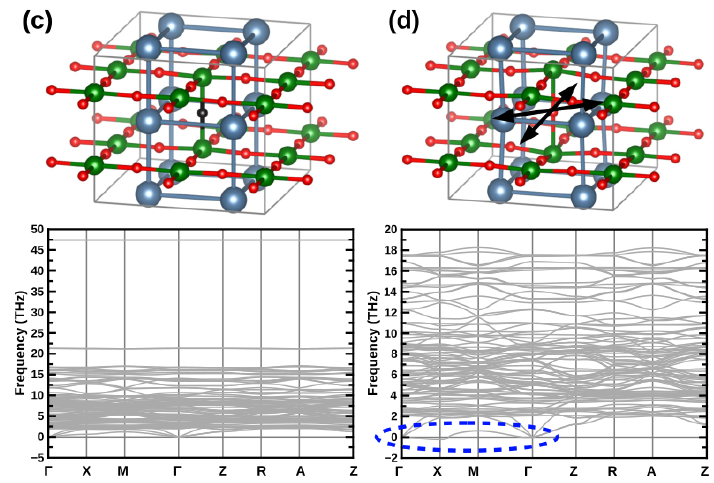
Figure 3. Phonon spectra of ( a ) LaNiO 2 and ( b ) LaNiO 2 H and in a 2 × 2 × 2 LaNiO 2 supercell doped with a single ( c ) H and ( d ) O atom (i.e., LaNiO 2 H 0.125 in ( c ) and LaNiO 2.125 in ( d )). The orange and black arrows in ( b , d ) represent vibrations of H and O atoms. The blue dashed oval in ( d ) labels the unstable phonon modes induced by intercalating additional O atoms in LaNiO 2 .